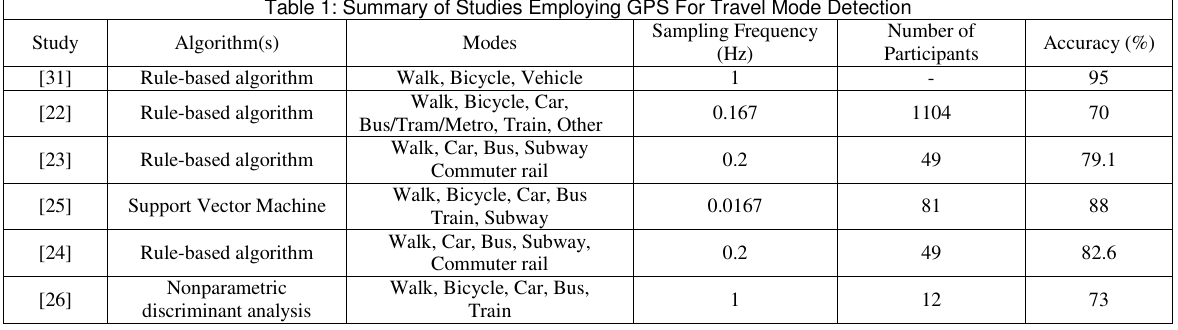
Table 1: Summary of Studies Employing GPS For Travel Mode